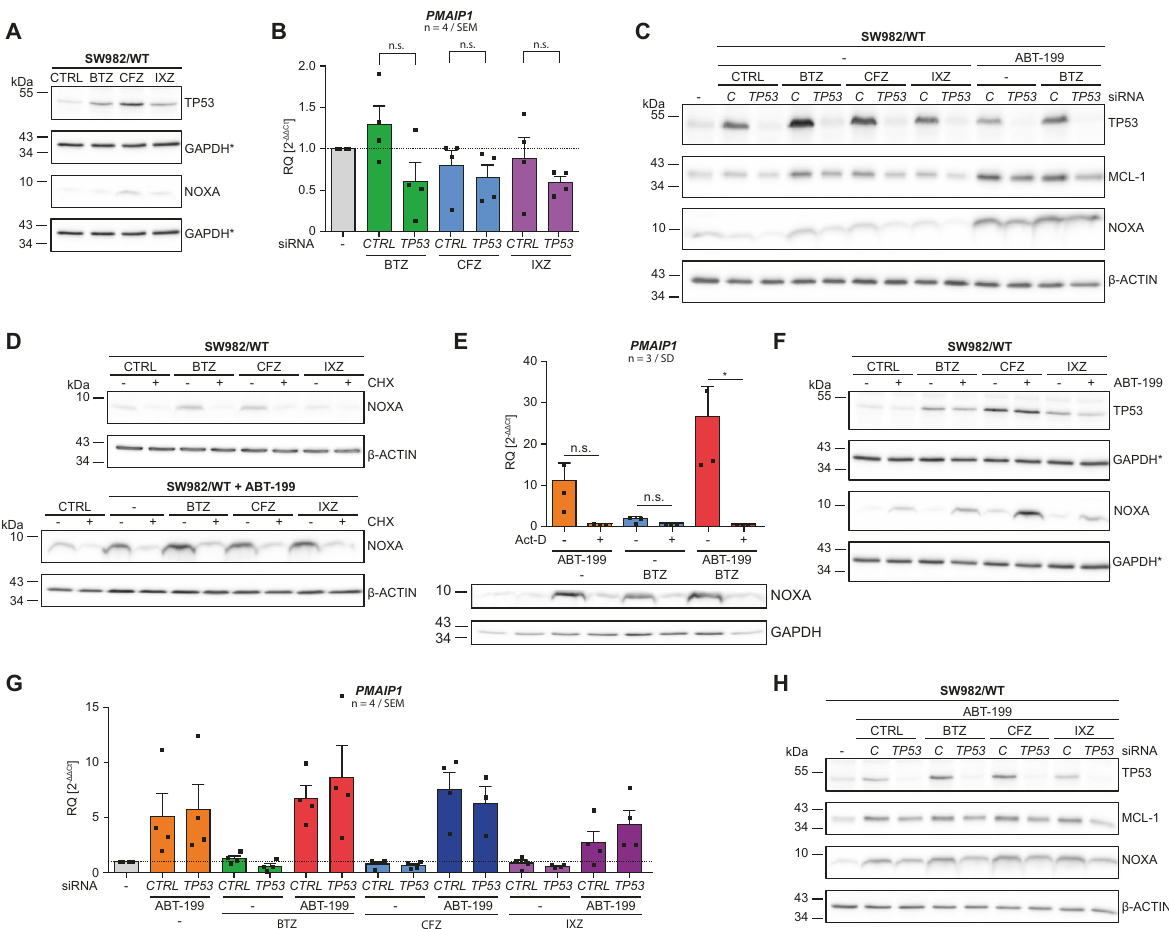
Fig. 3 Negligible TP53-dependent induction of NOXA by PIs. A Cells were incubated with 5 nM PI (BTZ, CFZ, IXZ; + 10 µM Q-VD-OPh) for 8 h and expression of TP53 and NOXA were analyzed by Western blot, using GAPDH as loading control. B , C Cells were transfected with si CTRL or si TP53 and subsequently incubated with indicated inhibitors for 8 h. B Expression of PMAIP1 was analyzed by qRT-PCR and C Western blot was performed to analyze expression of TP53, MCL-1, NOXA, and β -ACTIN (loading control). D Western blot analysis of SW982/WT incubated with PIs alone or in combination with ABT-199 ( + 10 µM Q-VD-OPh) for 8 h were carried out to analyze expression of NOXA ( β -ACTIN as loading control) in the absence or presence of 10 µM cycloheximide. E qRT-PCR and Western blot analysis of PMAIP1/ NOXA expression in SW982/ WT cells incubated with ABT-199, BTZ or ABT-199&BTZ for 8 h in the absence or presence of 1 µM actinomycin D were performed (GAPDH as loading control). F SW982/WT cells were incubated with BTZ, CFZ or IXZ in the absence or presence of ABT-199 for 8 h. Expression of NOXA (GAPDH as loading control) was analyzed by Western blot. G SW982/WT were transfected with si CTRL or si TP53 and incubated with the indicated PIs alone or in combination with ABT-199. Subsequently, PMAIP1 expression was analyzed by qRT-PCR. H SW982/WT cells were transfected with si CTRL or si TP53 and incubated with ABT-199 alone or in combination with BTZ, CFZ, or IXZ for 8 h. Cell extracts were analyzed for the expression of TP53, MCL-1 and NOXA by Western blot ( β -ACTIN as loading control). Graphs show mean and individual data points. Asterisks indicate identical Western blot due to cutting/reprobing. Act-D actinomycin D, BTZ bortezomib, CFZ car fi lzomib, CHX cycloheximide, IXZ ixazomib, CTRL alone and in combination with PIs was signi fi cantly stronger than SW982 cells. In line with previous data ABT-199 enhanced the induction by proteasome inhibition (Fig. 3G). Western blot showed expression of endogenous NOXA while expression of transgenic that induction of NOXA expression mainly depends on ABT-199 NOXA was unaffected (Suppl. Figure 3A). Noteworthy, these fi ndings demonstrate that ABT-199 alone and in combination with and is augmented by PIs. Thus, qRT-PCR (Fig. 3G) and Western blot (Fig. 3C, H) indicate that ABT-199 strongly induces expression of BTZ induces transcription of PMAIP1/ NOXA that translates into enhanced expression of NOXA (Fig. 3E, lower panel). We investigated a role of TP53 in enhanced expression of NOXA in response to ABT-199 with or without PIs. As noted, expression of NOXA was enhanced by ABT-199 and unleashed in combina- tion with BTZ or CFZ. In contrast, TP53 was slightly augmented by PIs but unaffected by ABT-199, implying TP53-independent NOXA induction (Fig. 3F). Nevertheless, we knocked down TP53 and analyzed ABT-199 and/or PI mediated PMAIP1 gene expression. ABT-199 alone and in combination with BTZ, CFZ and to a lesser each cell line, ABT-199&PIs synergistically induced cell death extent IXZ induced expression of PMAIP1 that was not affected by (Suppl. Figure 2A – C: Annexin V-APC; Suppl. Figure 2D – F: TMRM). In TP53 knock-down. Furthermore, PMAIP1 induction by ABT-199